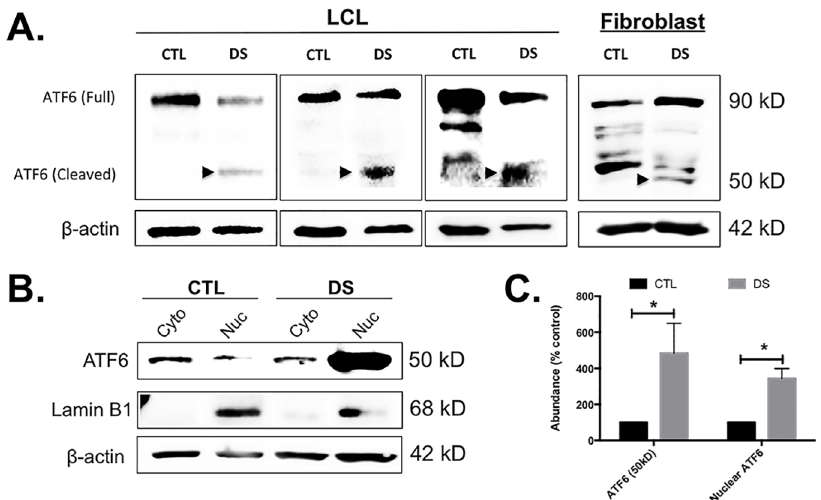
Fig 6. LCLs and fibroblasts from DS patients show increased ATF6 cleavage(A) and increased nuclear localization (B) compared to euploid controls. Both DS LCLs and fibroblasts displayedincreased ATF6 cleavage,as evidencedby the presence of a bandlocated at approximately 50 kD (arrow). Significantly increasedATF6 cleavageand nuclearlocalizationwas observedin the DS cells comparedto